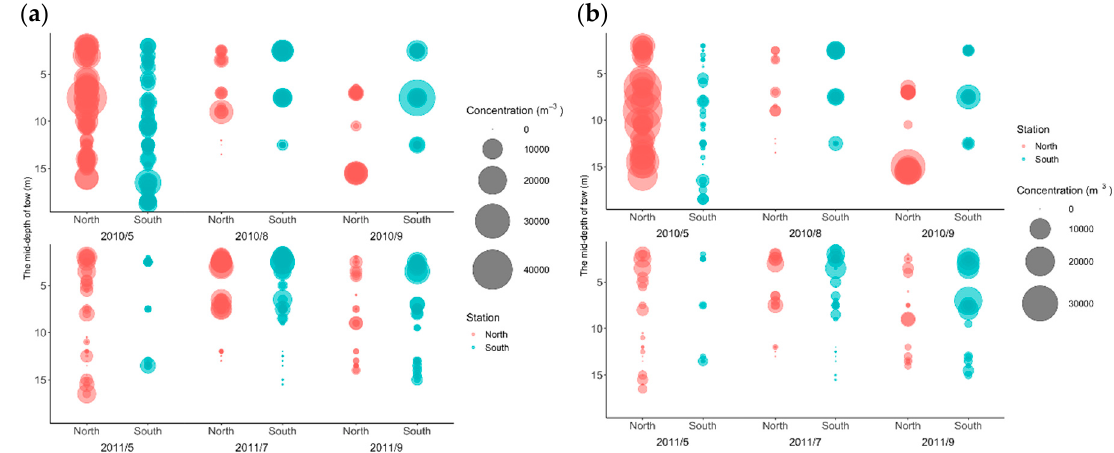
Figure 4. Concentrations of the copepod Acartia tonsa adults ( a ) and copepodites ( b ) collected at North (red) and South (green) station during the six research cruises from May, August / July, September in 2010 and 2011. Bubble sizes indicate population sizes (ind. m − 3 ).